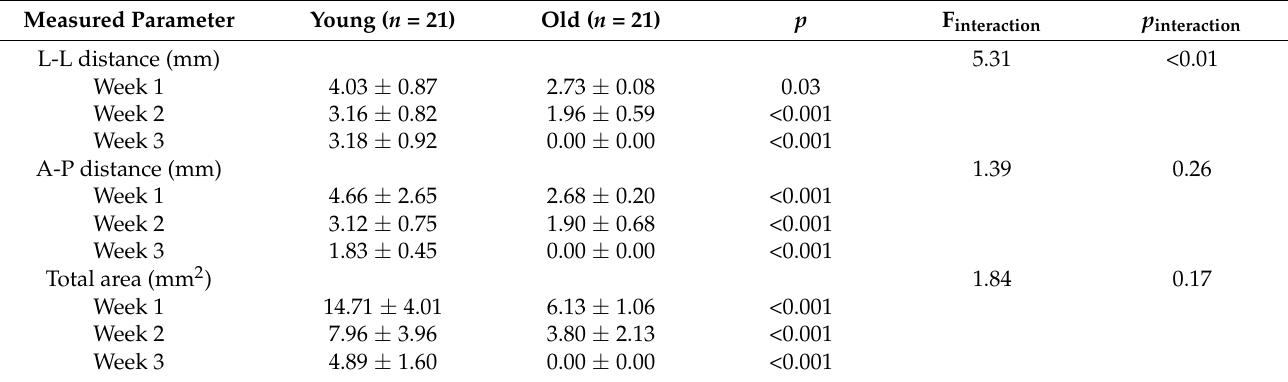
Table 1. Macroscopic wound area measurements, mean and standard deviation (SD) in young and old rats from week 1 to week